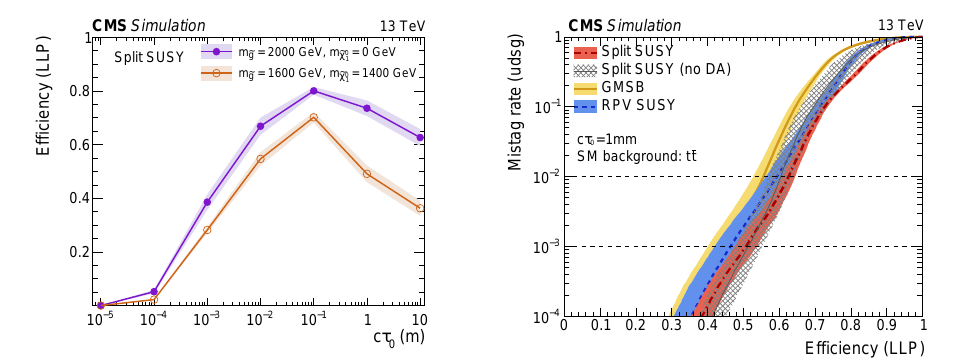
Figure 4. Performance of identifying LLP jets while rejecting udsg jets from an inclusive t¯t sample: (left) LLP jet selection e ffi ciency for a fixed background rate of 0.01% as a function of c τ 0 ; (right) the receiver operator characteristic (ROC) curves for three di ff erent LLP models with c τ 0 = 1mm. The figures are taken from Ref. [6].